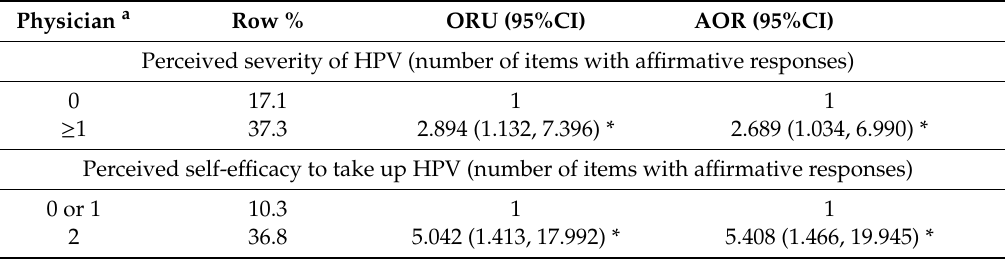
Table 4. Associations between composite cognitive indicator variables and intention to take up HPV